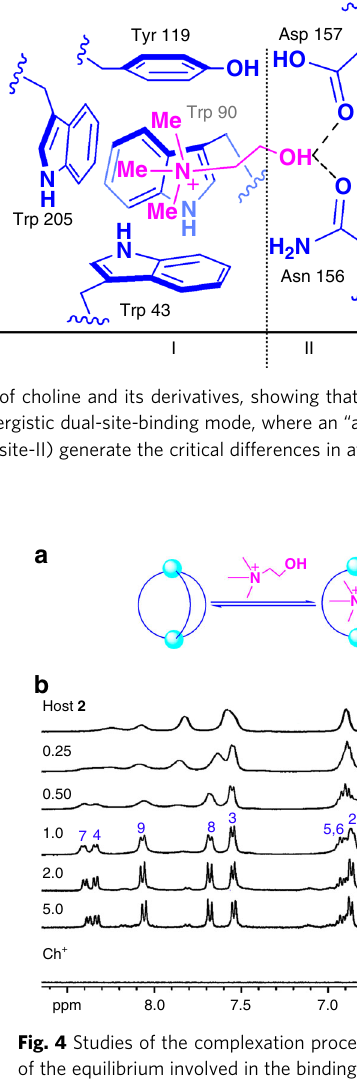
of the equilibrium involved in the binding of Ch • Cl by host 2 . b Stacking 1 H NMR (acetone- d 6 /1.5% D 2 O, 400 MHz) spectra of host 2 (TBA) 6 [(PO 4 ) 2 ( L ) 3 ] alone and in the presence of Ch • Cl (equiv. is labeled by numbers), and the spectrum of free Ch • Cl (blue squares TBA + , magenta circles Ch + , \ solvent